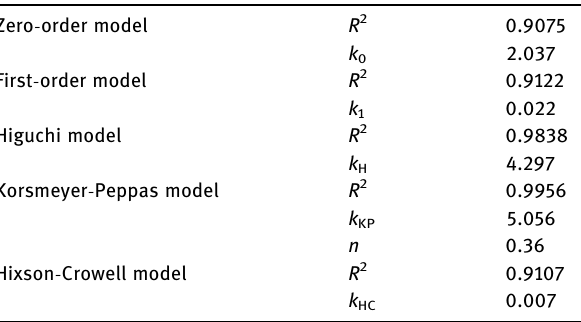
Table 3: In vitro release kinetic models and their